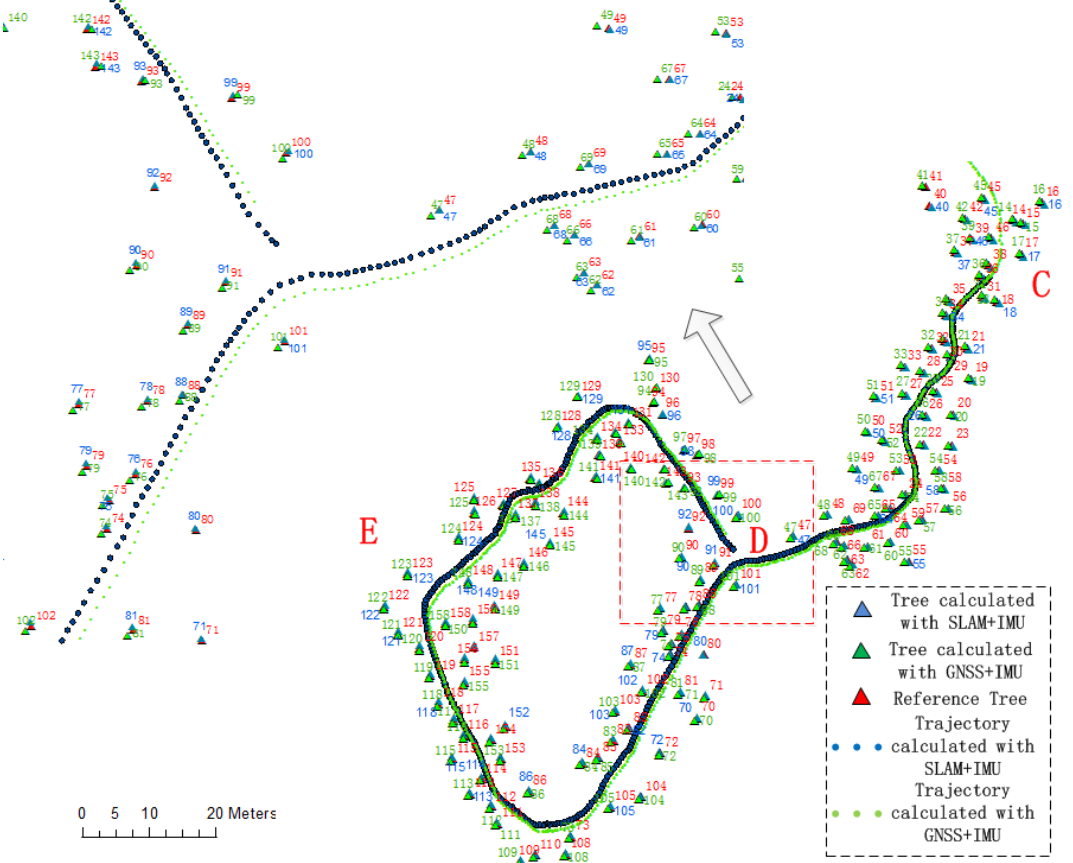
Figure 11. Trajectories and stem position comparison between the GNSS + IMU and SLAM + IMU methods in a feature-rich environment. Green dots are the trajectory of GNSS + IMU; blue dots are the trajectory of SLAM + IMU; red triangles are the reference tree position; green triangles are the tree positions calculated by the GNSS + IMU method; blue triangles are the tree positions calculated by the SLAM + IMU method.